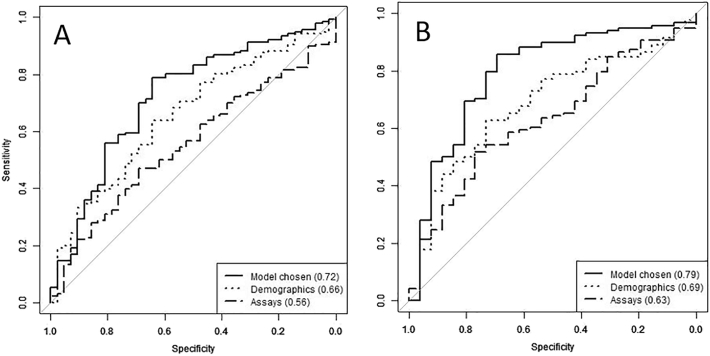
Receiver operated characteristic (ROC) curves to predict the probability of FEP compared to control subjects. The first model (A) comprised demographics (sex, age, ethnicity) and contributing analytes TCC and CRP; this gave an AUC statistic of 0.72. The values of sensitivity and specificity were respectively 0.79 and 0.64, with a minimised difference probability threshold (MDT) of 0.72.The second model (B) included tobacco smoking status as an additional demographic factor and contributing analytes comprised C3, C4, C5, TCC, C1inh, FHR125, CR1; this gave an AUC statistic of 0.79. This model has respective sensitivity and specificity of 0.85 and 0.69, with MDT = 0.78.